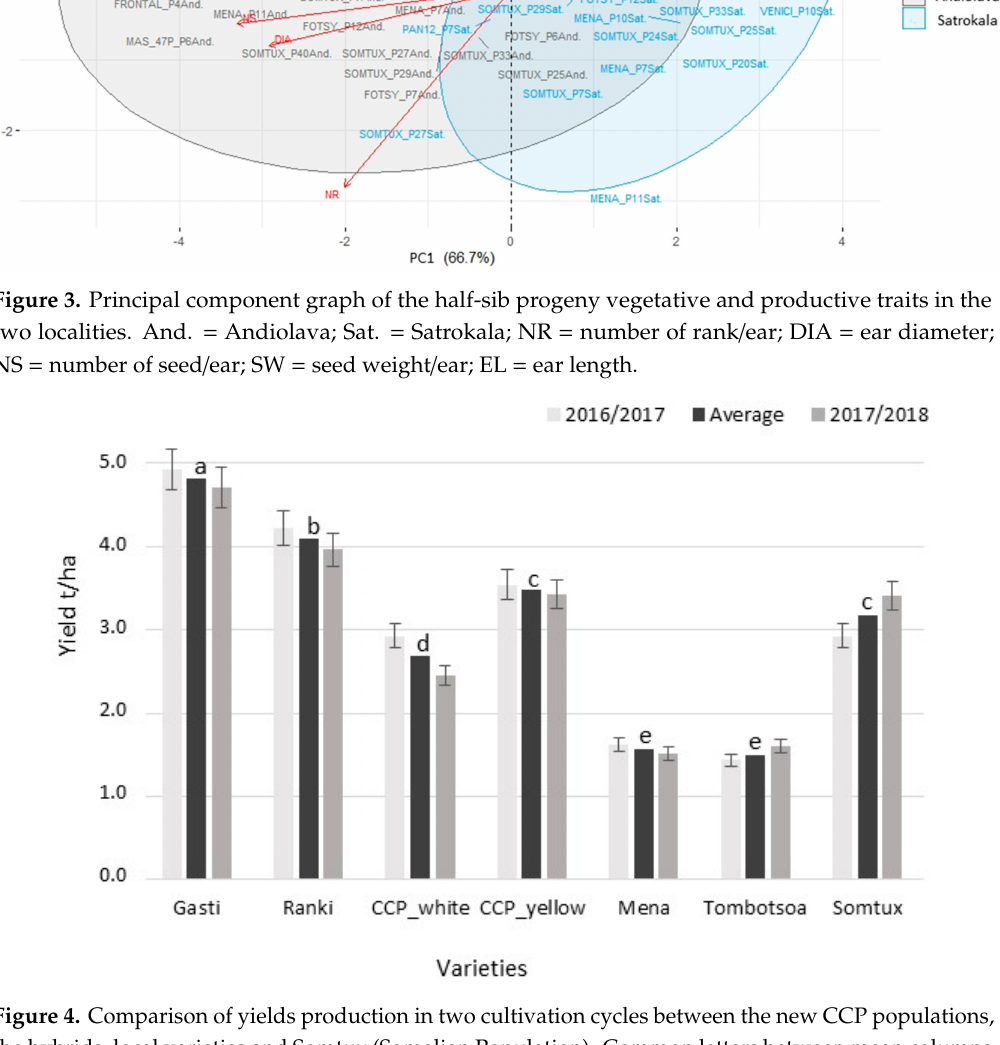
Figure 4. Comparison of yields production in two cultivation cycles between the new CCP populations, the hybrids, local varieties and Somtux (Somalian Population). Common letters between mean columns are not significantly different ( p > 0.05).